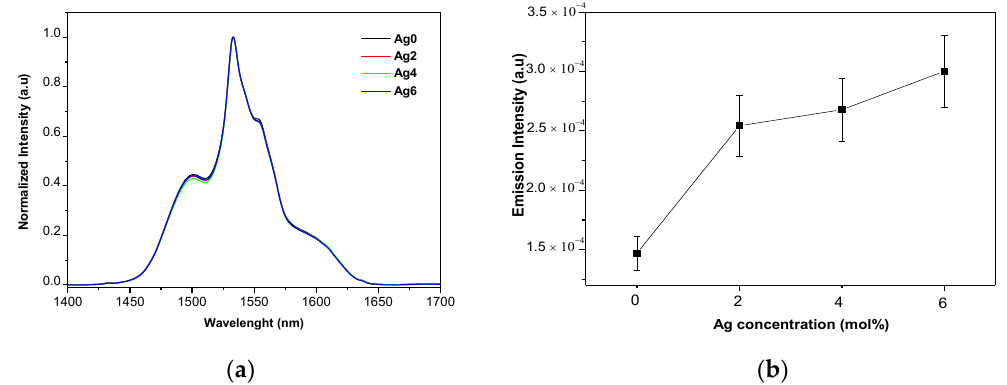
Figure 4. ( a ) Normalized emission band; ( b ) intensity of the emission at 1.53 µm as a function of x. The 4 I 13 / 2 lifetimes are listed in Table 5. Table 5. Er 3 + :I 13 / 2 measured lifetime ( τ m ) values of the investigated glasses ( ± 0.1 ms). Measured Lifetimes